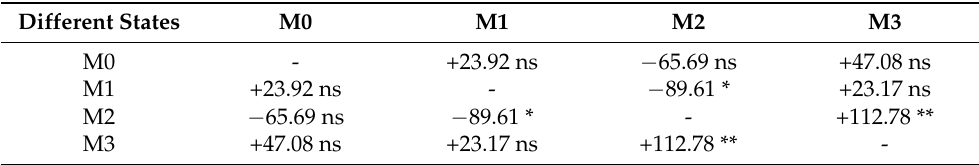
Table 4. The statistical significance of differences between various degrees of individual involvement. Different States M0 M1 M2 M3 M0 - +23.92 ns − 65.69 ns +47.08 ns M1 +23.92 ns - − 89.61 * +23.17 ns M2 − 65.69 ns − 89.61 * - +112.78 ** M3 +47.08 ns +23.17 ns +112.78 **